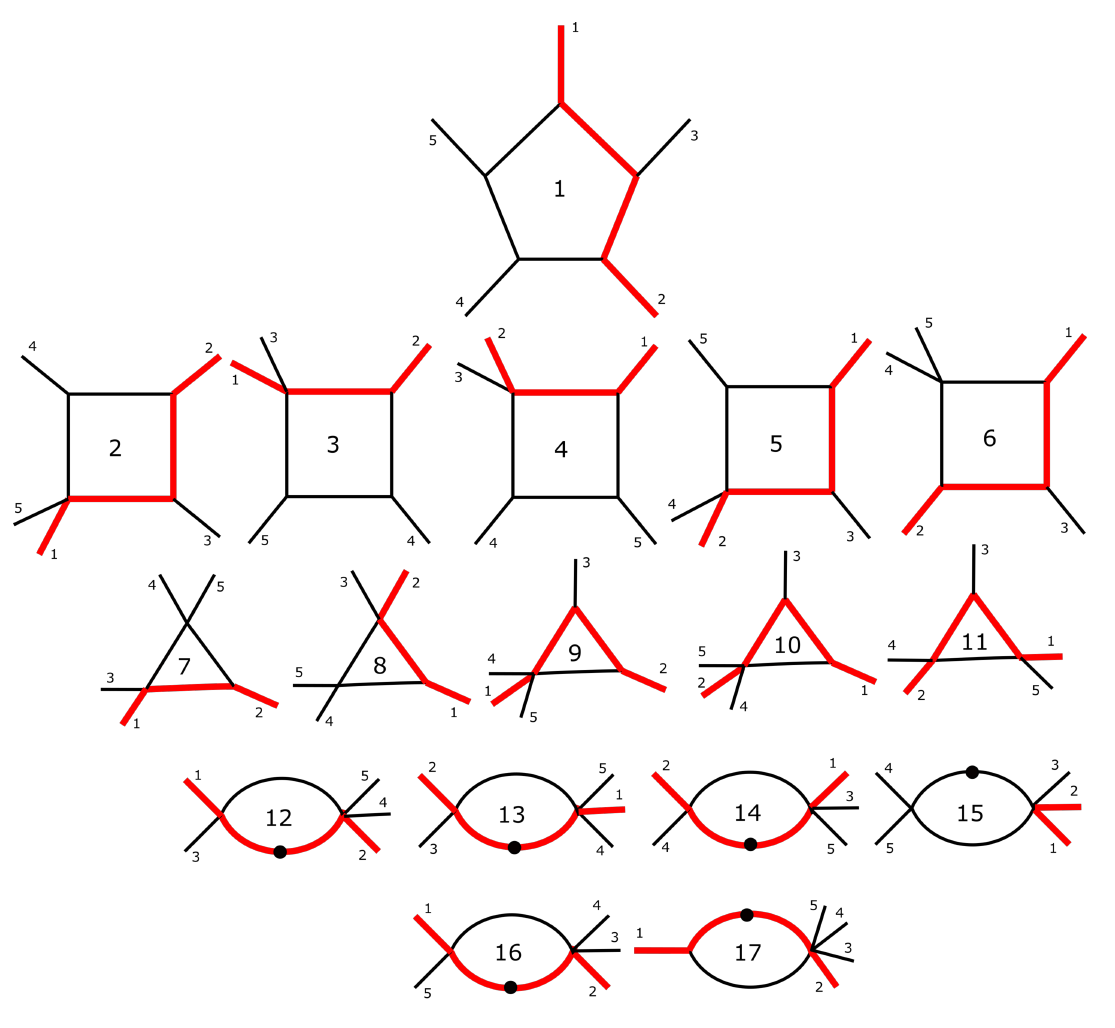
Figure 5 . The 17 master integrals appearing in topology T 3 , denoted by I ’s in (4.19). Red/black lines indicate massive/massless particles respectively. Dotted internal lines indicate propagators with an additional power in the denominator of the integral. Each integral is associated with a kinematic normalisation which ensures the basis leads to a canonical form differential